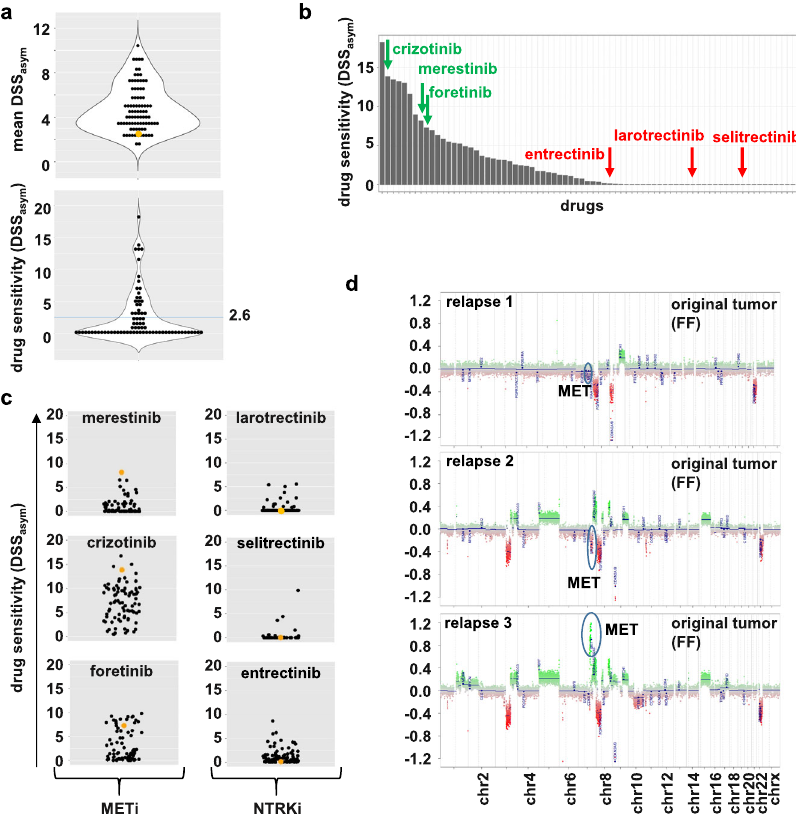
Fig. 7 Case report #1: NTRK fusion-positive high-grade glioma with acquired resistance to NTRKinhibitors due to MET ampli fi cation. a Violin dot plots displaying the mean DSS asym values for the whole cohort (upper graph) and each drug for the respective sample (lower graph; blue line: mean). The sample of interest (here, case #1 relapse 3) is marked in orange. b Waterfall plot sorting all tested drugs for the case #1 relapse 3 sample upon their DSS asym values, starting with the highest on the left. c Dot plots depicting the DSS asym values for the indicated drugs for all successfully screened samples. The sample of interest (here, case #1 relapse 3) is marked in orange. All three MET inhibitors (merestinib, crizotinib, foretinib) show above-average responses, whereas the three NTRK inhibitors all have a DSS asym of or close to 0. d Copy-number pro fi les of the FF samples reveal an acquired (or selected) MET amp in the plot for relapse